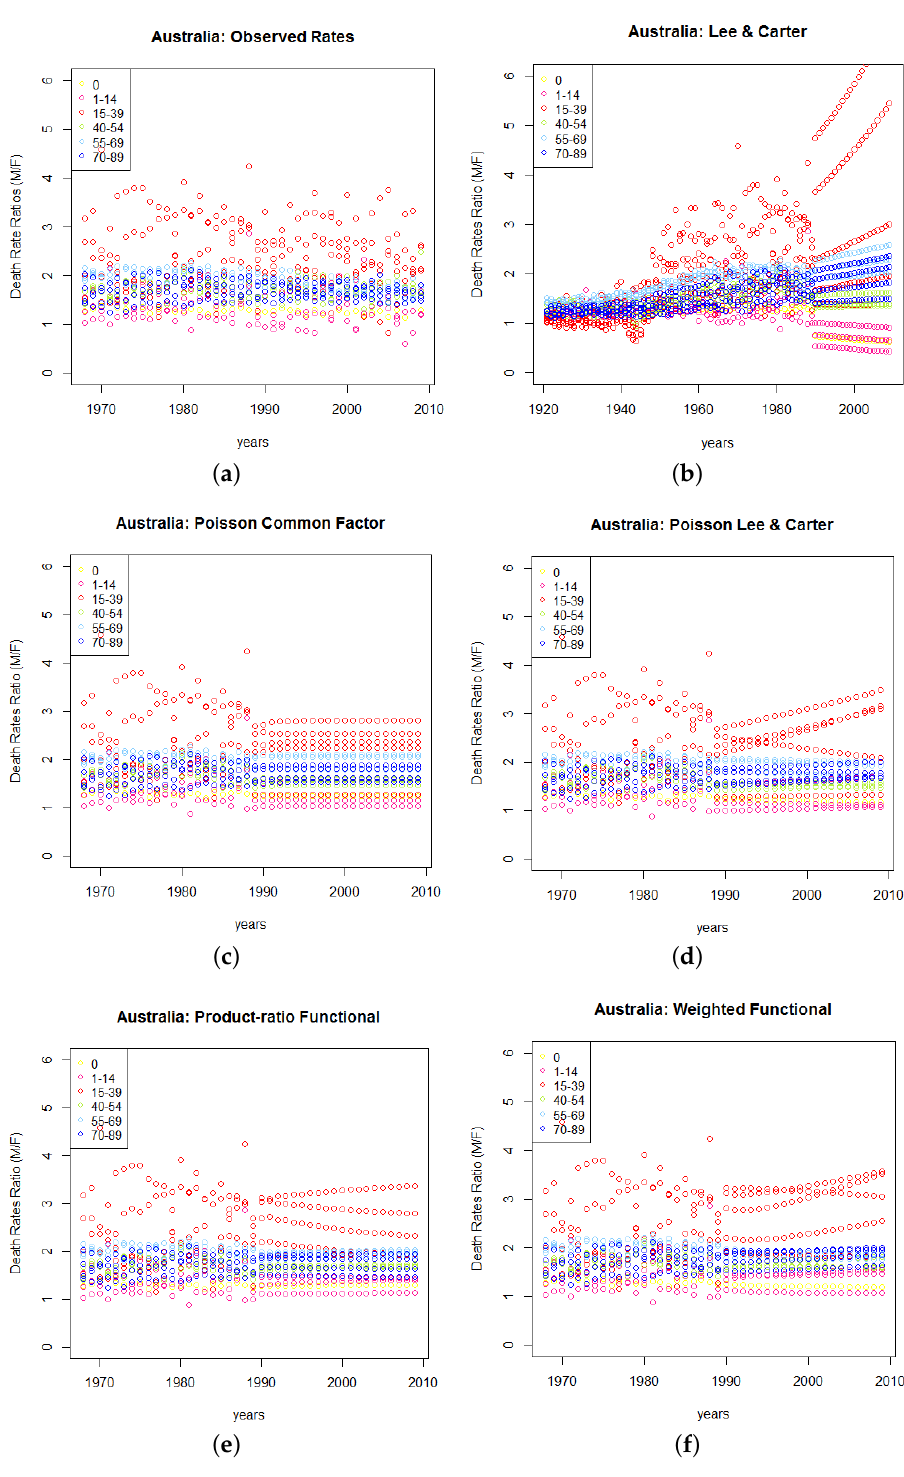
Figure 4. ( a ) Australian observed male-to-female death rate ratios 1968–2009, followed by forecasts of these ratios from 1989–2009 using ( b ) Lee-Carter, ( c ) Poisson common factor, ( d ) Poisson-Lee-Carter, ( e ) Product-ratio functional and ( f ) Weighted functional